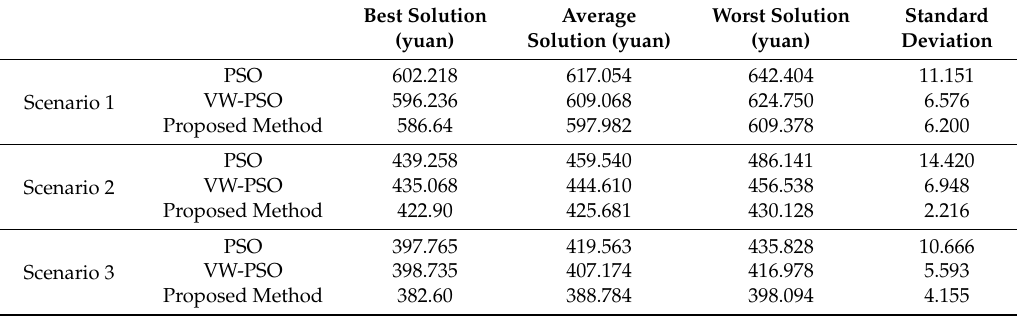
Table 6. Statistics of 20 operating results for three different optimization algorithms.